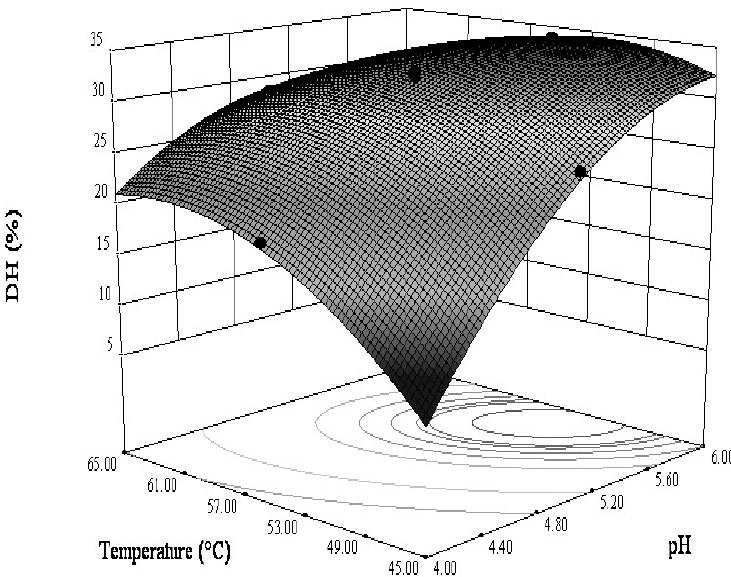
Figure 4. The combined effect of constant pH and hydrolysis temperature on the DH at protein concentration (20 g/L) and papain amount (0.5 g/L).